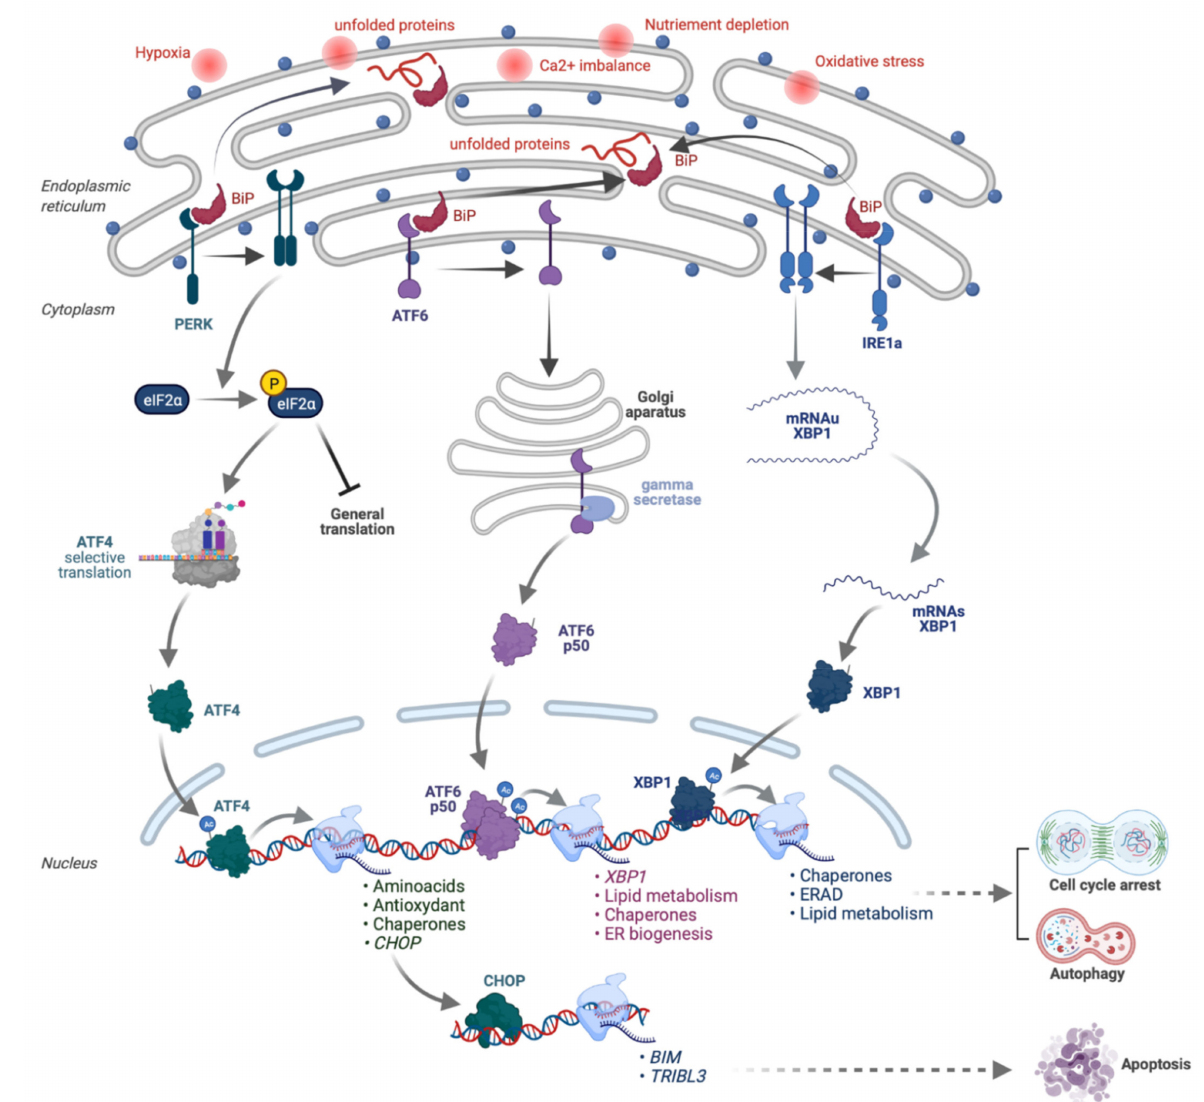
Figure 4. Reticulum endoplasmic stress response pathway. Designed with